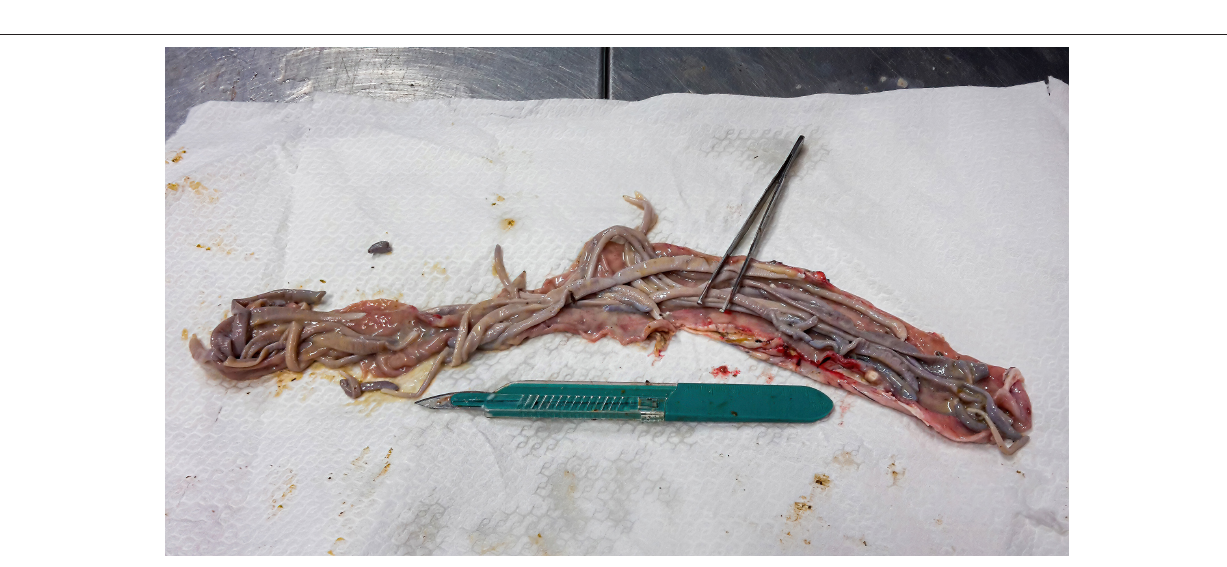
Frontiers in Veterinary Science |